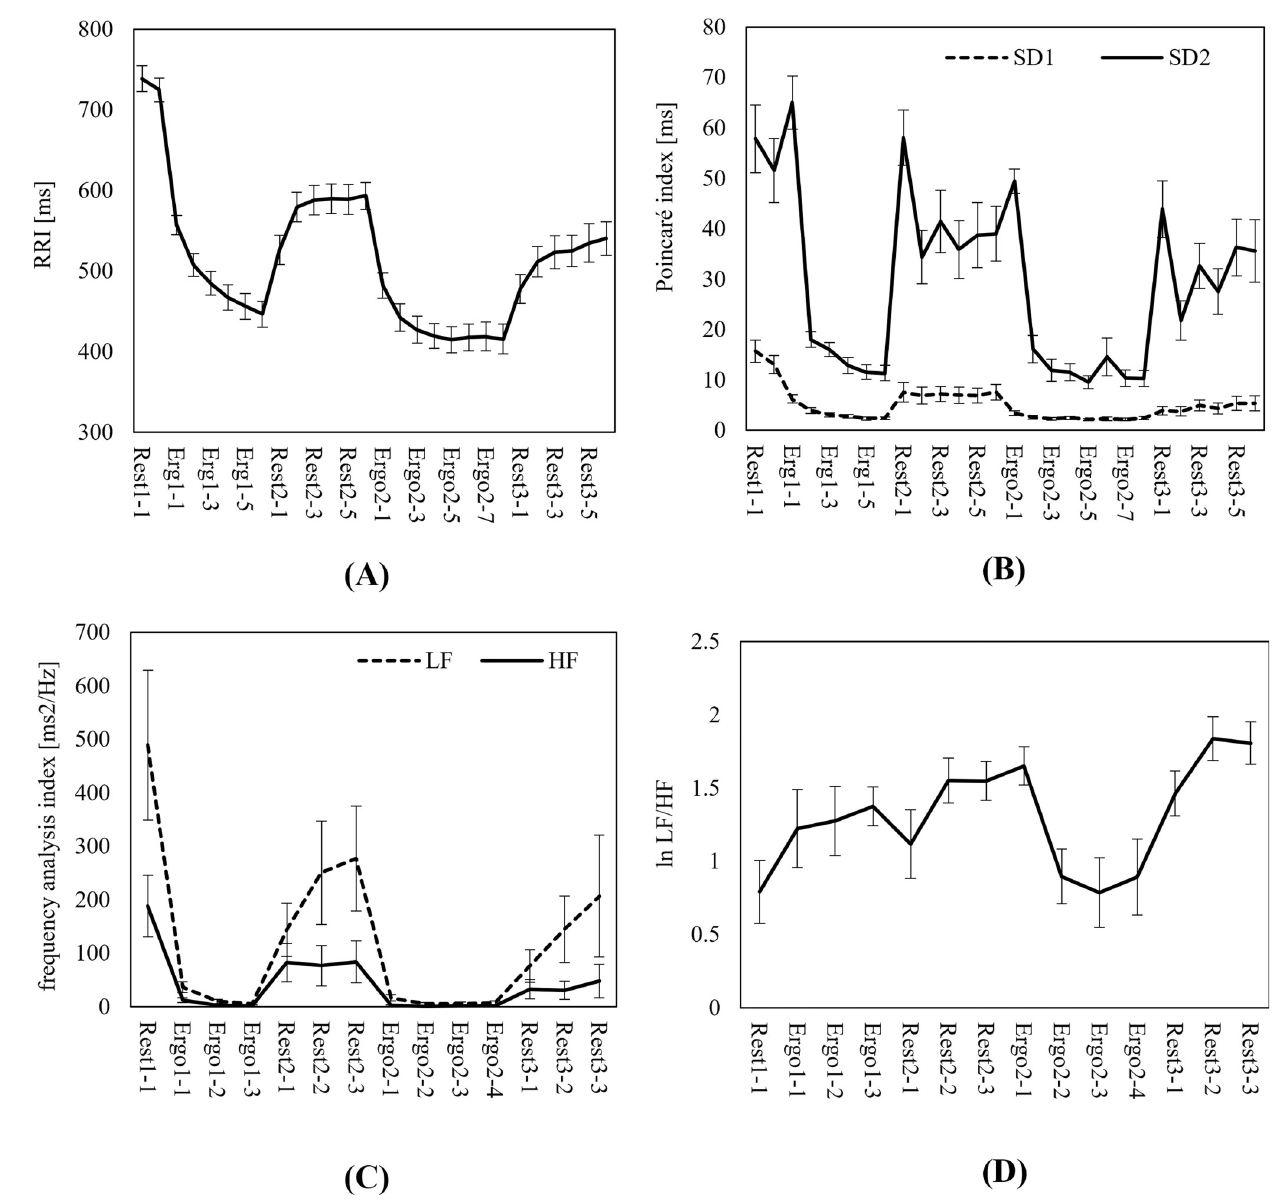
Fig 2. Temporal changes in ECG indexes (mean ± SE). (A) RR interval. The RRI average dropped rapidly according to the exercise load and did not return to the pre-exercise state during rest. (B) Poincare´ plot index. SD2 exhibited the same trend as RRI. The change in state from the exercise load to resting state was remarkable. (C, D) Frequency analysis indexes LF/HF. The LF and HF components essentially disappeared during exercise loads, and thus may not be suitable for evaluation under those conditions in the stipulated frequency